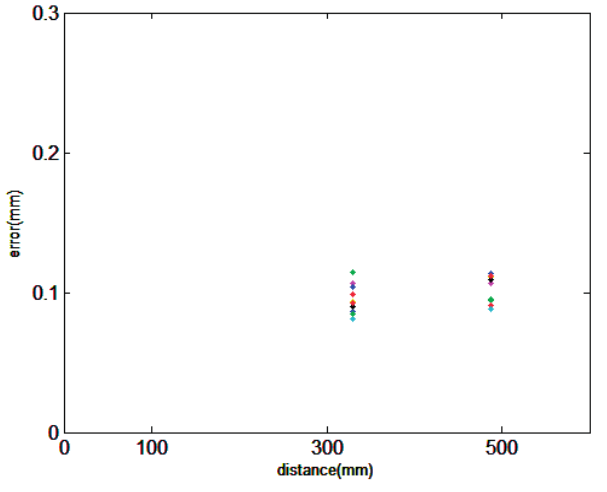
Figure 7. The layout of the reference global position points.